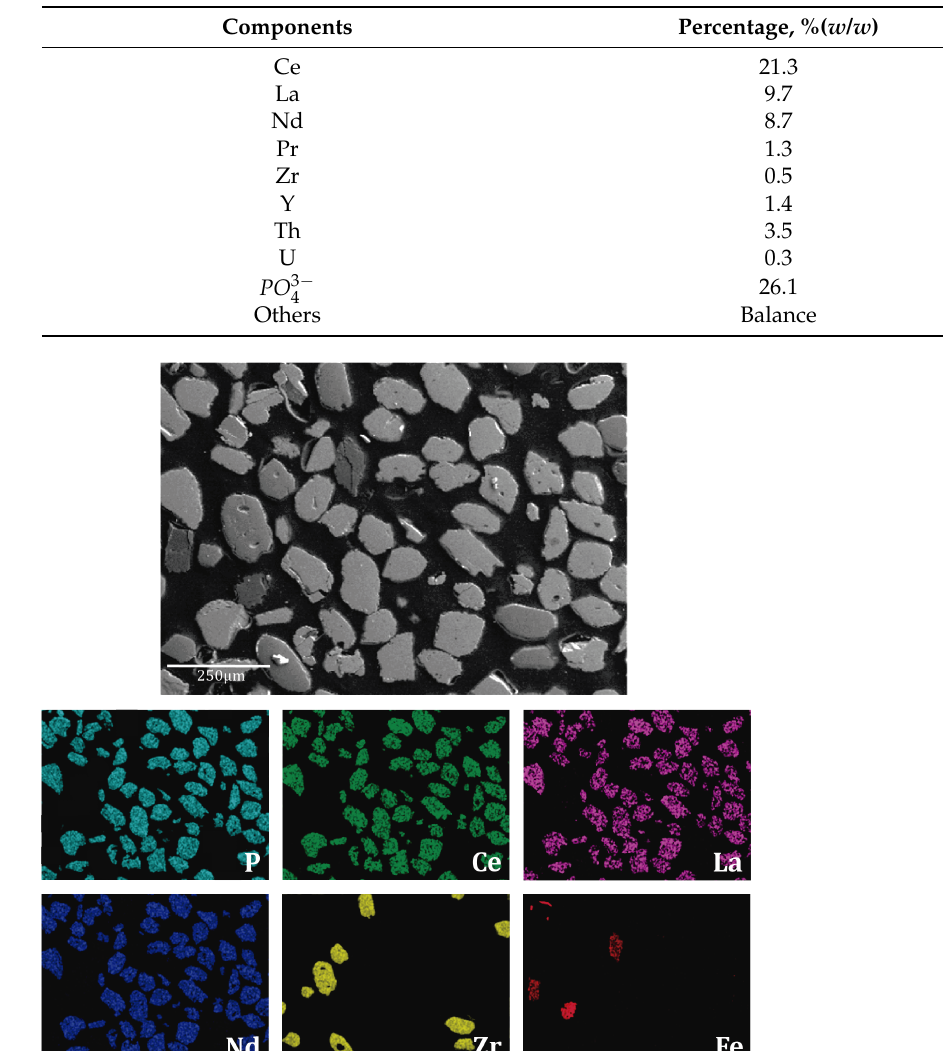
Table 2. Chemical composition by ICP-OES of the monazite concentrate sample.